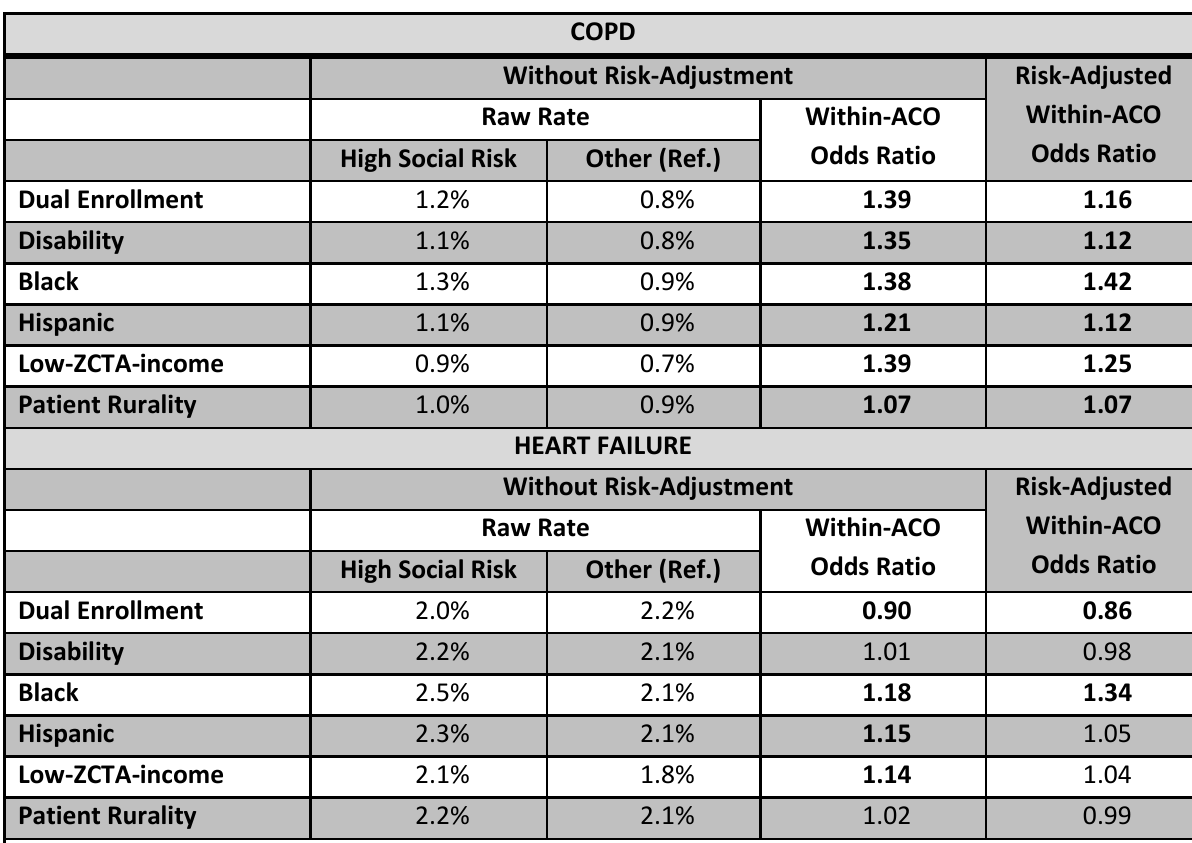
Table 9.4: Beneficiary Social Risk Factors and Performance on Medicare Shared Savings Program PQI Measures